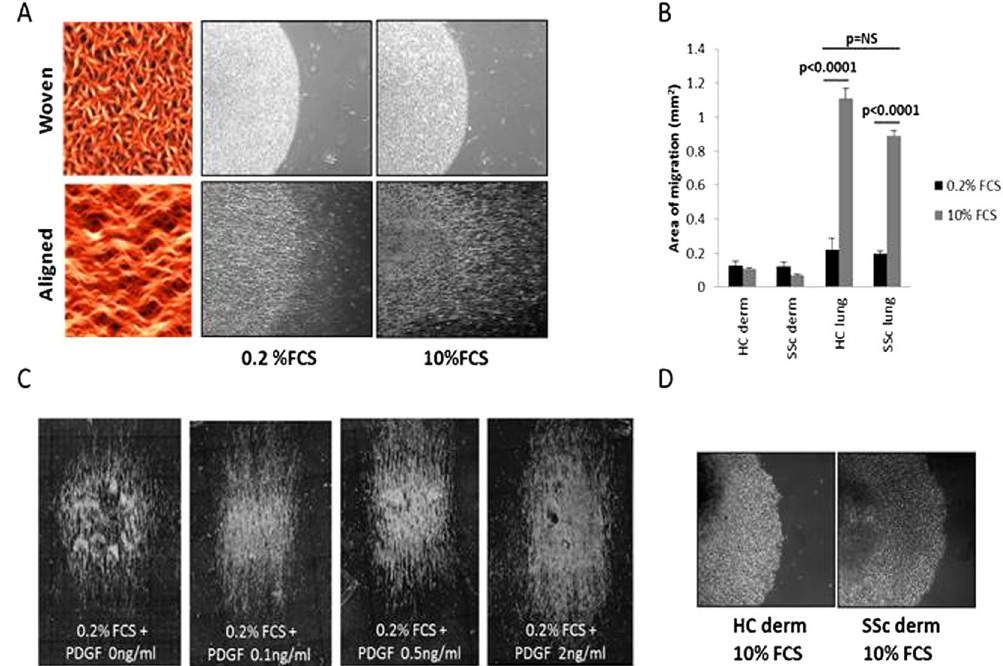
Figure 1. Migration of lung fibroblasts on aligned collagen dependent on serum and PDGF. Fibroblasts were applied to the patterned collagen substrates as 3 µ l drops containing 4000 cells per µ l, allowed to adhere and then cultured further in DMEM with 0.2% or 10% FCS or with PDGF-BB. Healthy control (HC) lung fibroblasts did not migrate on the woven collagen substrates, but remained as adherent cellular foci. However, when cultured on aligned collagen these cells elongated and migrated parallel to the aligned collagen fibrils, enhanced by 10% FCS. 24 hour time point shown ( A ). HC and SSc lung fibroblasts showed a similar magnitude of enhanced migration with FCS 10% versus 0.2% at 24 hours ( B ). The additon of PDGF 0.1–2.0 ng/ml enhanced normal lung fibroblast migration when cultured on the aligned collagen in media containing FCS 0.2% ( C ). Dermal fibroblasts (derm) did not consistently align or migrate on either substrate, but remained as non-migrating cellular foci, 24 hour time point shown ( D